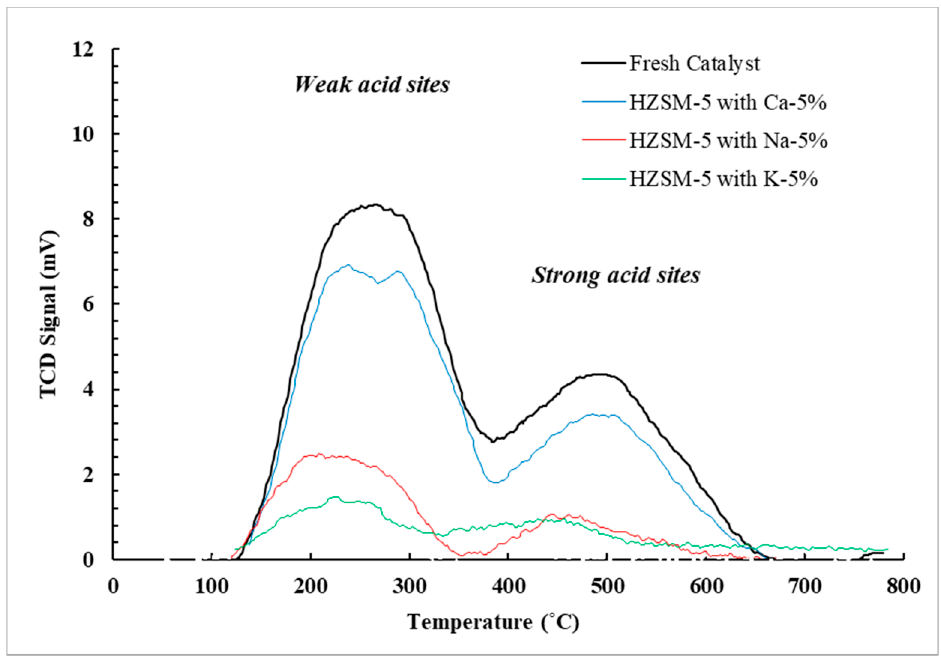
Figure 2. NH 3 -temperature programmed desorption profiles from the H + ZSM-5 catalysts deactivated with inorganic species.